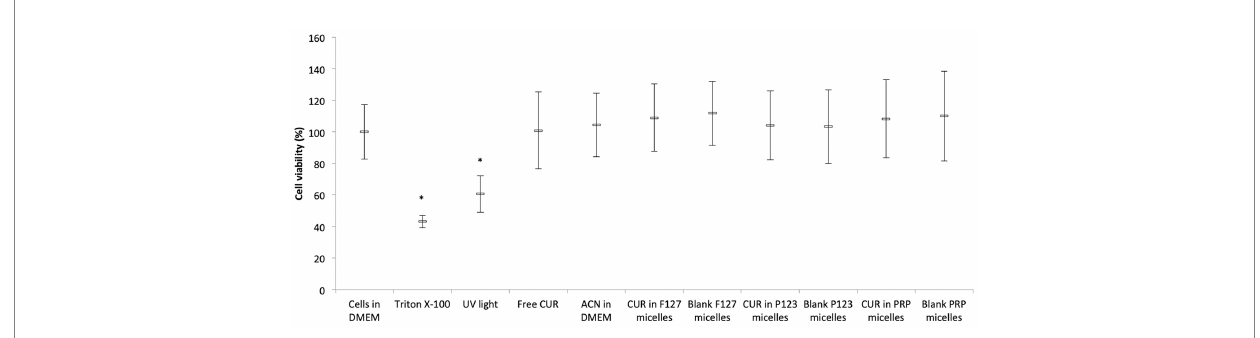
FIGURE 5 Mean values (%) of MTT after incubating NOK cells with CUR-loaded micelles. Error bars: standard deviation ( n = 12). Asterisks (*) denote significant differences ( p < 0.05) among the groups. The data analyzed by ANOVA/Welch and Games-Howell post-hoc tests.